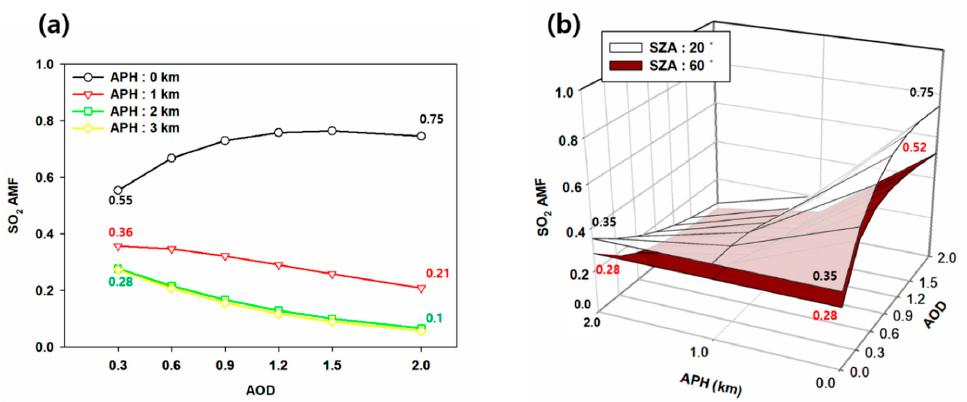
Figure 7. ( a ) Changes in PBL SO 2 AMF as a function of AOD for various APH, and ( b ) simultaneous e ff ects of AOD and APH at low and high SZA (VZA = 40 ◦ ; RAA = 45 ◦ ; surface reflectance = 0.05; effects of AOD and APH at low and high SZA (VZA = 40°; RAA = 45°; surface reflectance = 0.05; O 3 O 3 VCD = 275 DU; wavelength = 318 nm; APH = 0 VCD = 275 DU; wavelength = 318 nm; APH = 0 km).